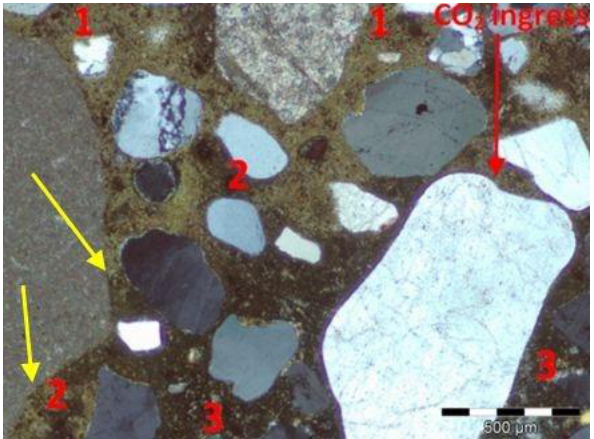
Figure 8. Microstructure of the partially carbonated zone in concrete with limestone aggregate and CEM I: 1—totally carbonated matrix; 2—partially carbonated matrix, 3—non-carbonated matrix; XPL, scale bar = 500 µm.